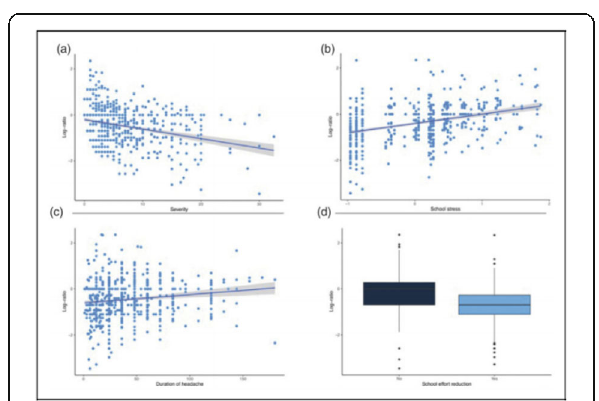
Fig. 2 (abstract AL07). See text for